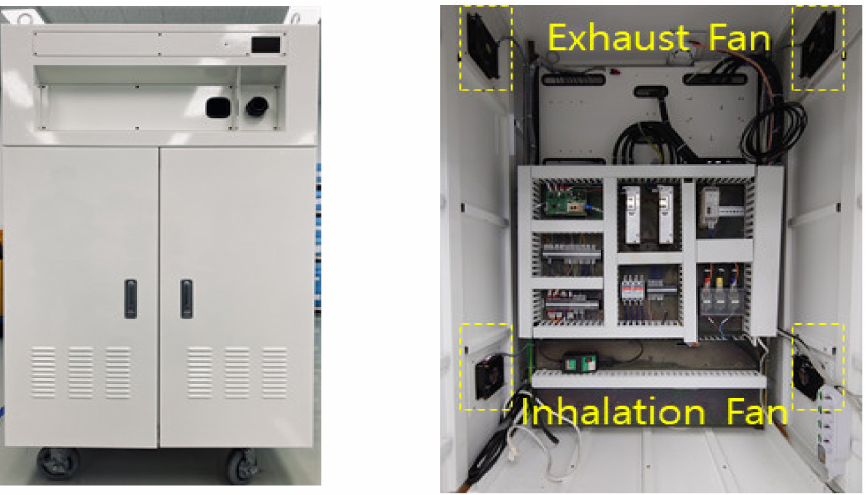
Figure 6. Distribution panel manufactured for experiment with installed exhaust and inhalation fans.